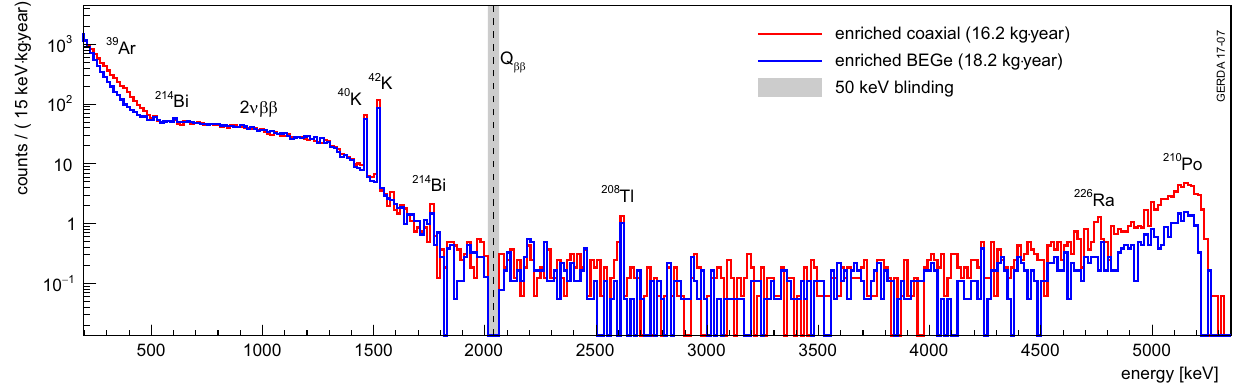
Fig. 30 Normalized Gerda Phase II background spectra from BEGe and enriched coaxial detectors before pulse shape discrimination and LAr veto. The grey bar indicates the blinded energy region around Q